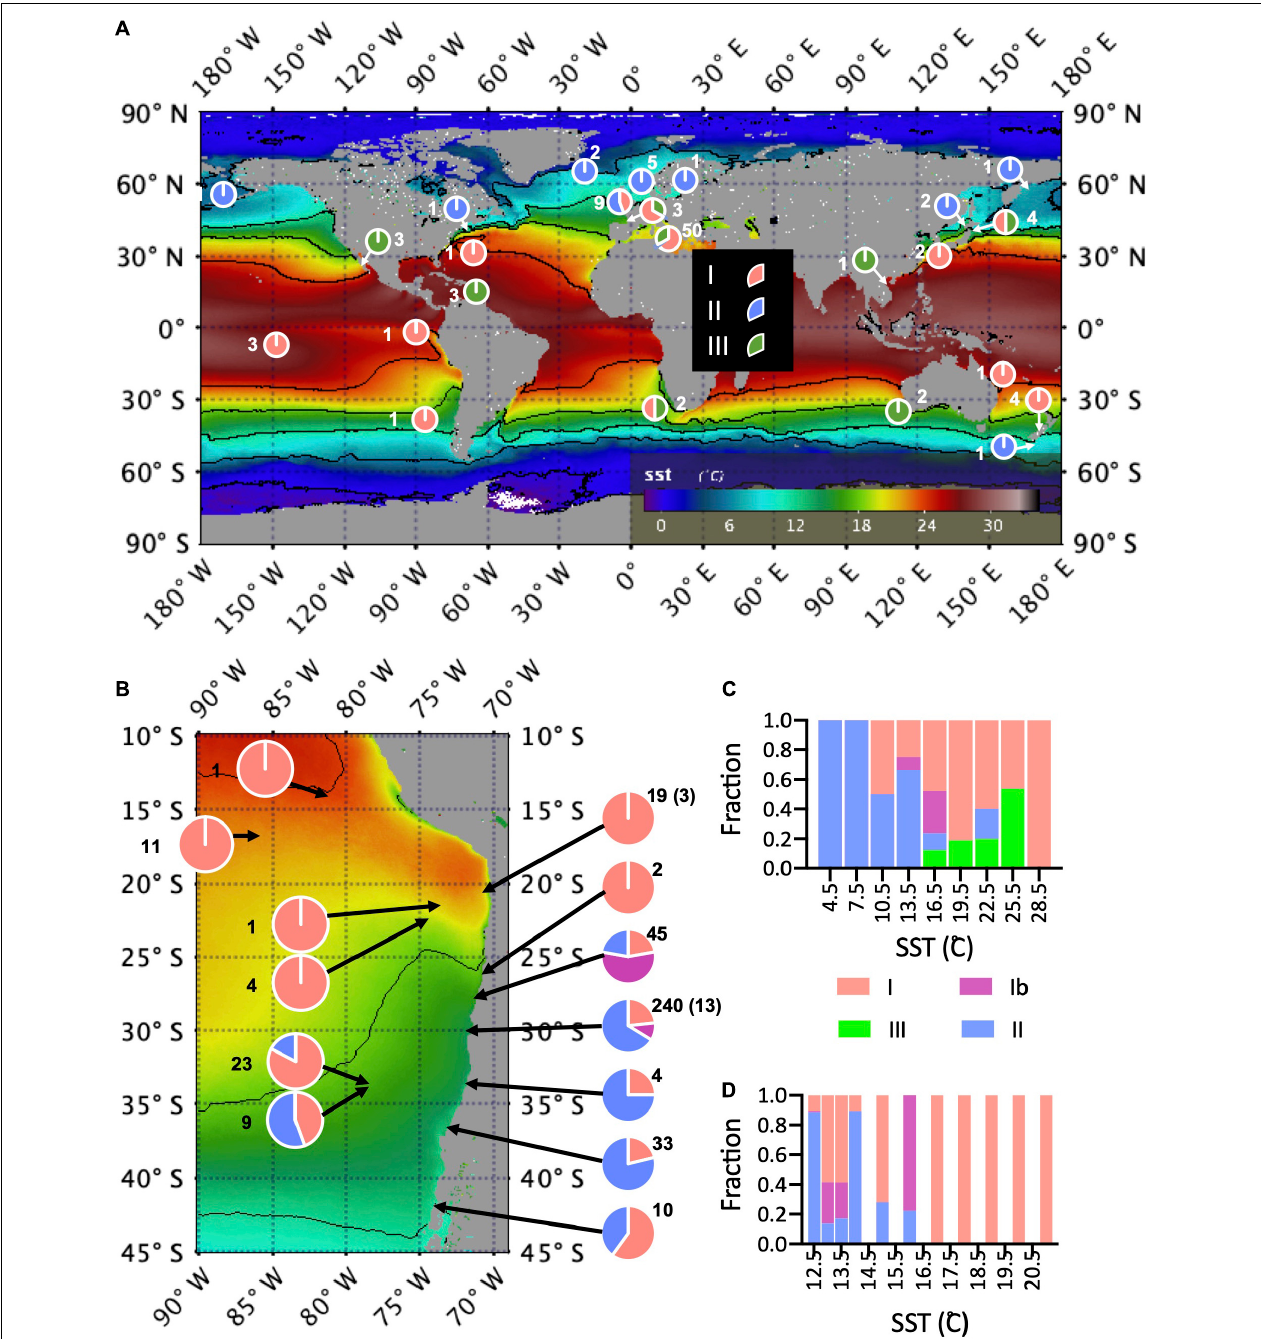
FIGURE 4 | (A) Global distribution of strains each haplogroup at sites of origin. Pie charts show proportions of strains in each haplogroup at each site of origin, overlayed on map of mission average SST from MODIS Terra. Numbers of strains are indicated by each pie chart. Sites that are very close are consolidated. (B) The same map of SST, but zoomed into the Southeast Pacific. (C) The proportion of each haplogroup in temperature bins, including all strains. Here temperature was extracted for each month/year and site of origin from the Multi Observation Global Ocean ARMOR3D L4 analysis and multi-year reprocessing. (D) The proportion of each haplogroup in temperature bins for strains from the Southeast Pacific for which direct measurements of surface (5 m) temperature and salinity are